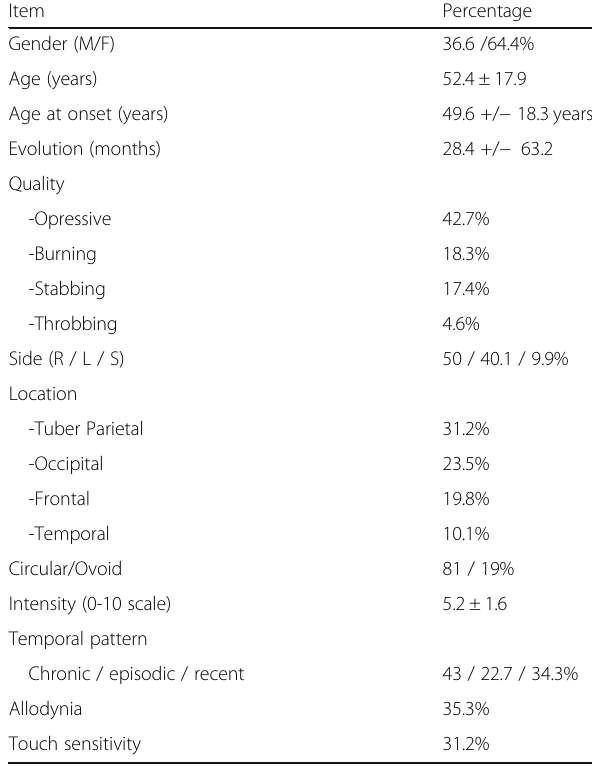
Table 1 Demographic and clinical features of NH (n: